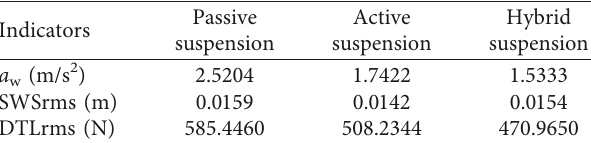
Table 4: The dynamic response root mean square values of the hybrid suspension in suburban circulation unit.